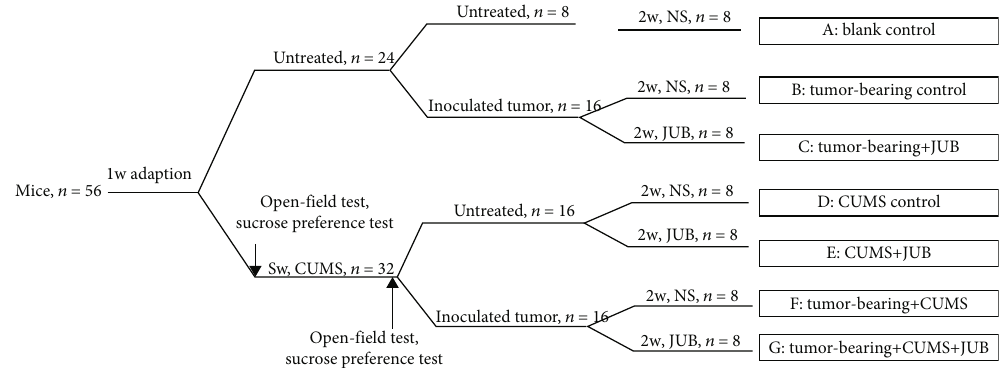
Figure 1: The fl ow chart of this whole study.